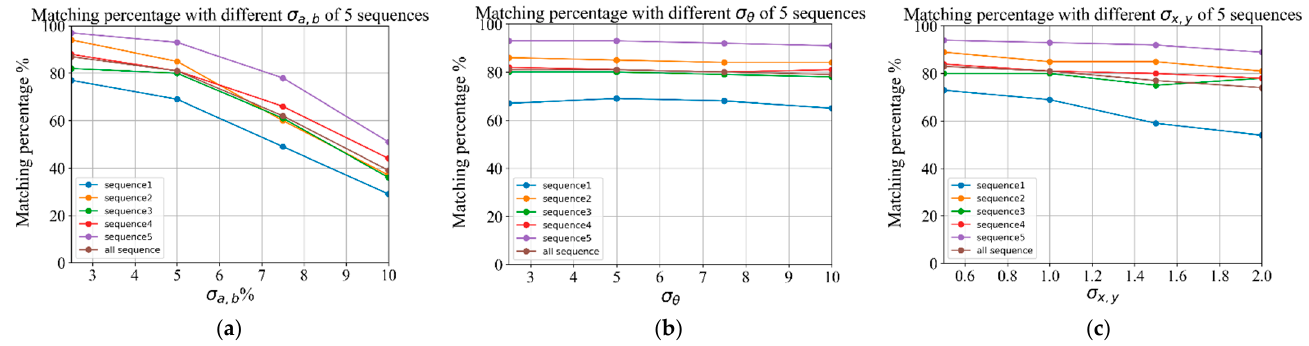
Figure 17. Matching percentage with different noise for five